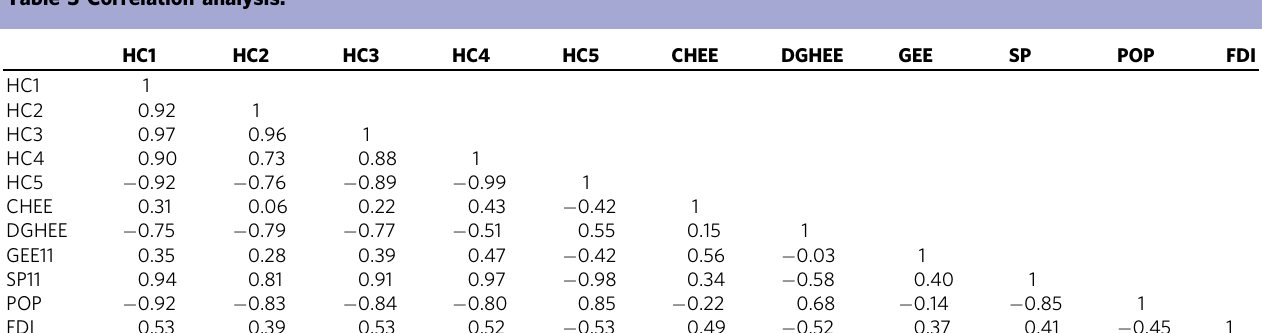
Table 3 Correlation